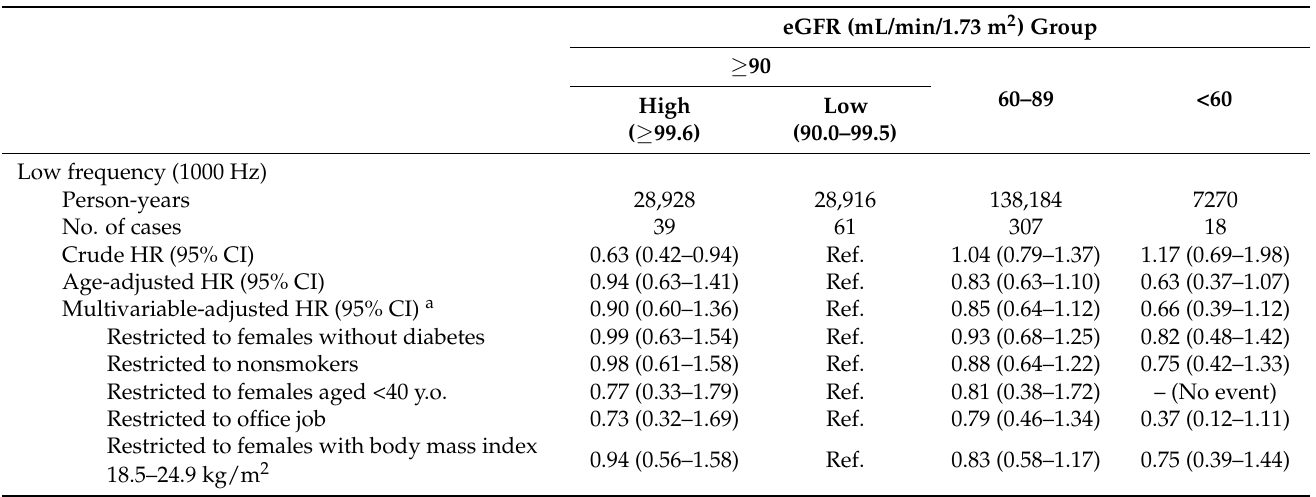
Table 4. Hearing impairment according to estimated glomerular filtration rate group in female